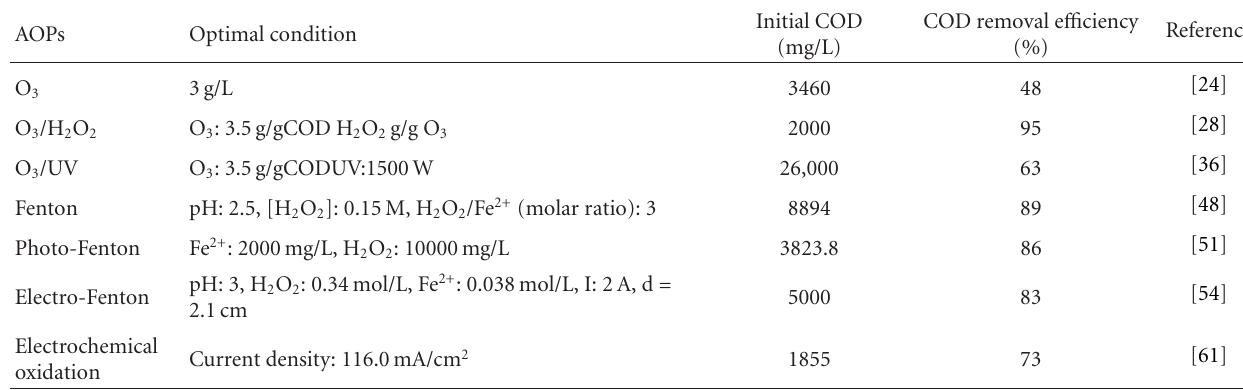
Table 6: Summary of the highest reported COD removal of some